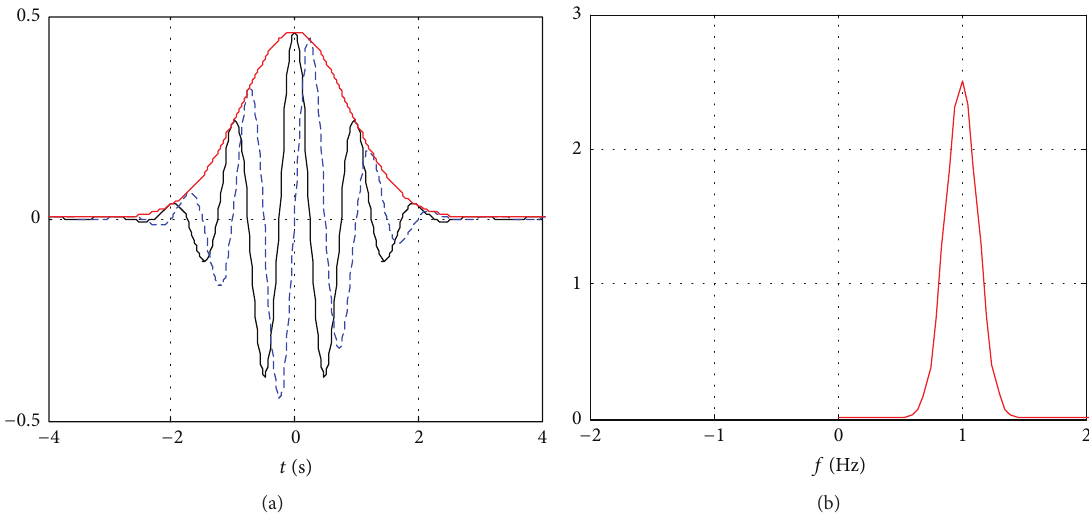
Figure 5: Complex Morlet wavelet. (a) Real part (black line), imaginary part (dash line), and envelope (red line); (b) FFT of the complex Morlet